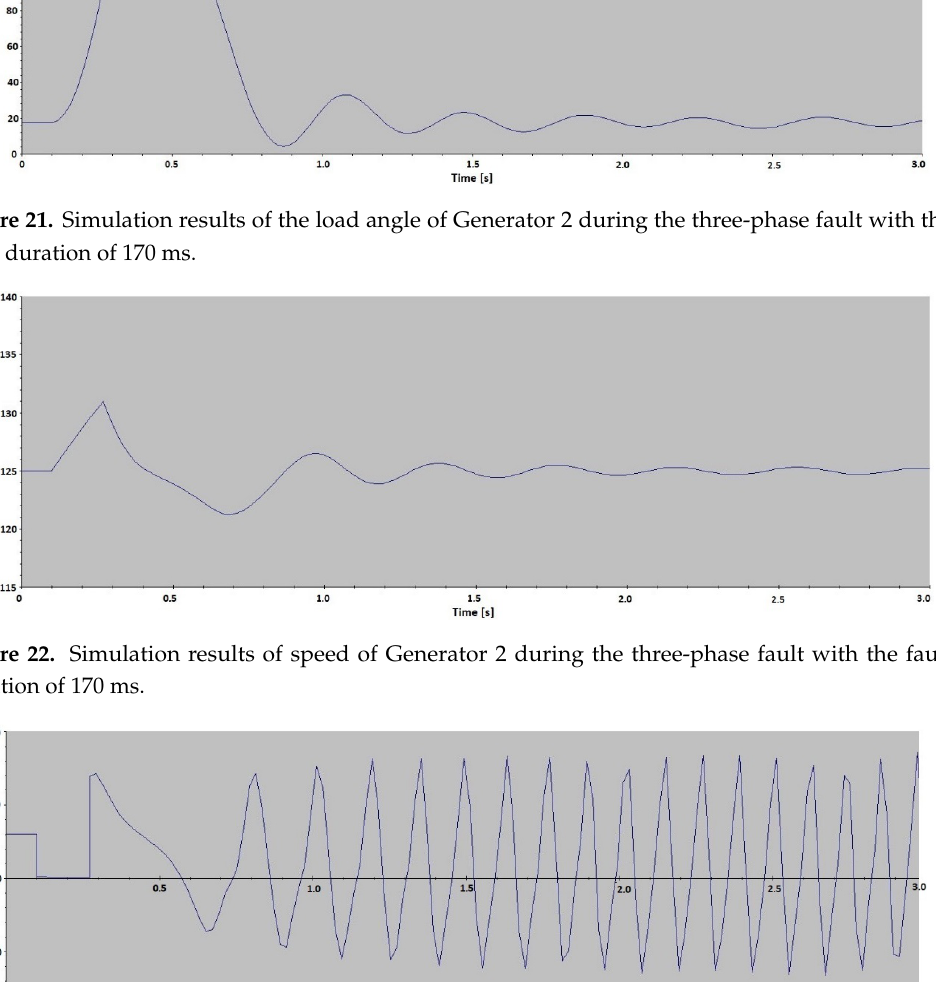
Figure 21. Simulation results of the load angle of Generator 2 during the three-phase fault with the fault duration of 170 ms.